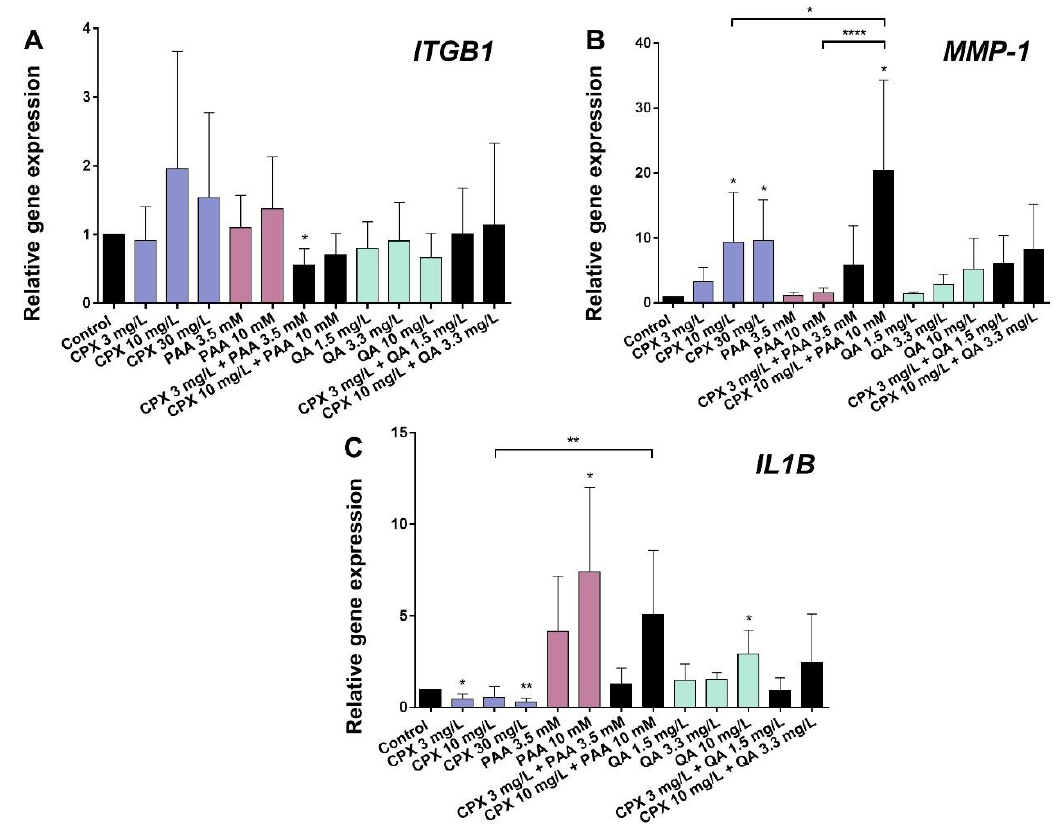
Figure 5. Gene expression of β 1 -integrin ( ITGB1 ), MMP-1 , and IL-1β ( IL1B ) in human tenocytes after 72 h incubation with CPX alone and with PAA and QA, alone and in combination with CPX. ( A ) ITGB1 , ( B ) MMP-1 , and ( C ) IL1B . Gene expression was normalized using the reference-gene hypoxanthine phosphoribosyltransferase ( HPRT ) and compared to the untreated control. Bars show the mean ± SD (five to six independent experiments with cells of five to six different donors were included). * p ≤ 0.05, ** p ≤ 0.01, **** p ≤ 0.001 compared to control.